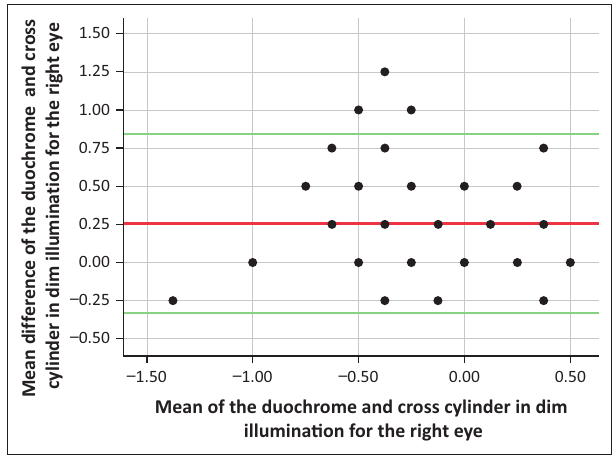
FIGURE 1: Box plot for the measurements of the duochrome and unfused cross cylinder tests for the right eyes. The boxes show the median and the first and third quartiles. The whiskers represent the range of the measurements.